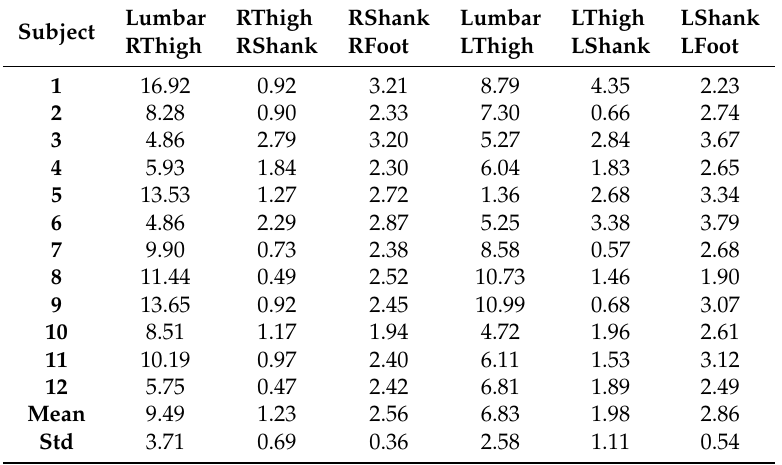
Table 6. RMSE in centimeters of total distance between each IMU pair, per